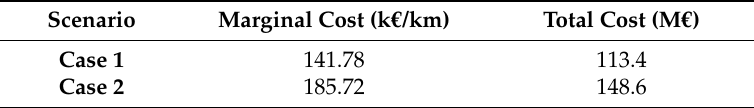
Table 11. DC lines estimated costs in the two cases analyzed.